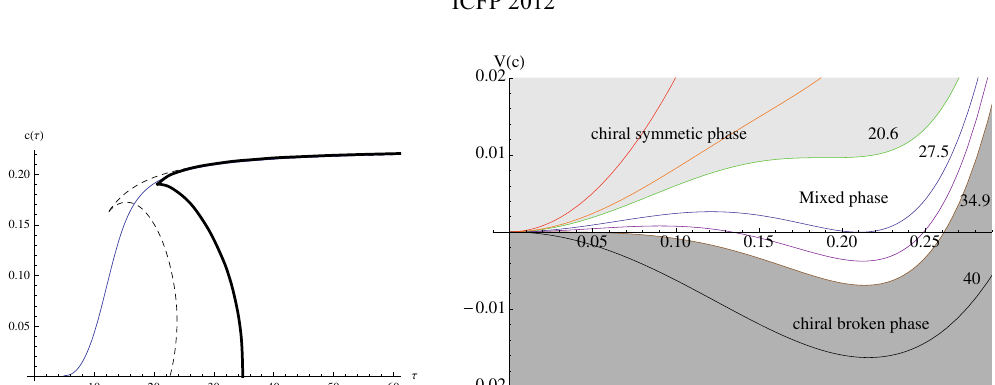
Figure 7. Results for time dependence of the condensate through the first order phase transition in the N = 2 gauge theory with magnetic field. Left: The condensate c ( t ) in the equilibrium and non-equilibrium (blue) approaches. In the equilibrium description, the di ff erent branches correspond to the extrema of the potential V ( c ) on the Right.